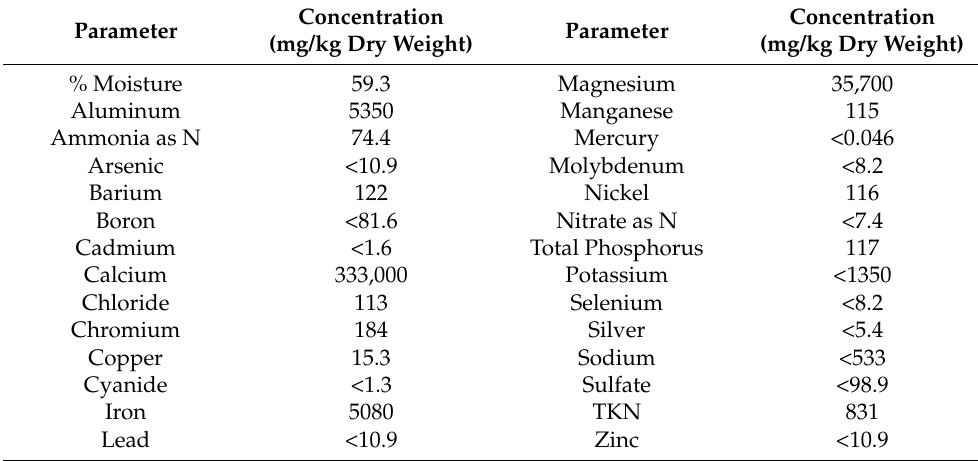
Table 1. Physiochemical characterization of spent lime DWTR used in the P removal